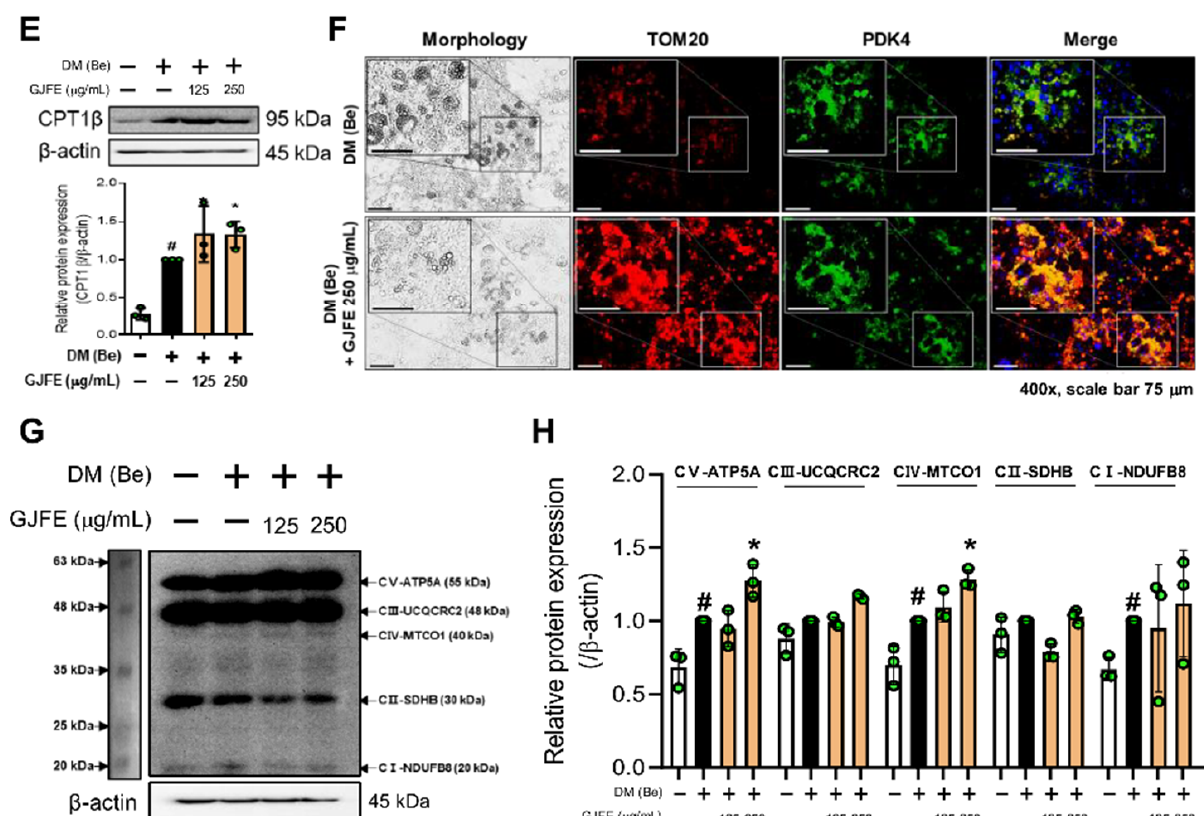
Figure 5. Effect of GJFE on mitochondrial activation in beige-induced 3T3-L1 cells. Mitochondrial membrane potential was measured by JC-1 staining in beige-induced 3T3-L1 cells treated with GJFE (250 µ g/mL) by ( A , B ) immunofluorescence staining and ( C , D ) flow cytometry. ( E ) Protein level of CPT1 β was analyzed by Western blot analysis. ( F ) Protein levels of TOM20 (red), PDK4 (green), and DAPI (blue) were detected by immunofluorescence staining (magnification 400 × , scale bar 75 µ m). ( G , H ) Protein levels of OXPHOS complex were analyzed by Western blot analysis. β -actin was used as a loading control for Western blot analysis. All data are expressed as the mean ± SEM of the data from three or more separate experiments. # p < 0.05 vs. DM (Be)-untreated 3T3-L1 cells, * p < 0.05 vs. DM (Be)-treated 3T3-L1 cells. GJFE, Gardenia jasminoides fruit extract.